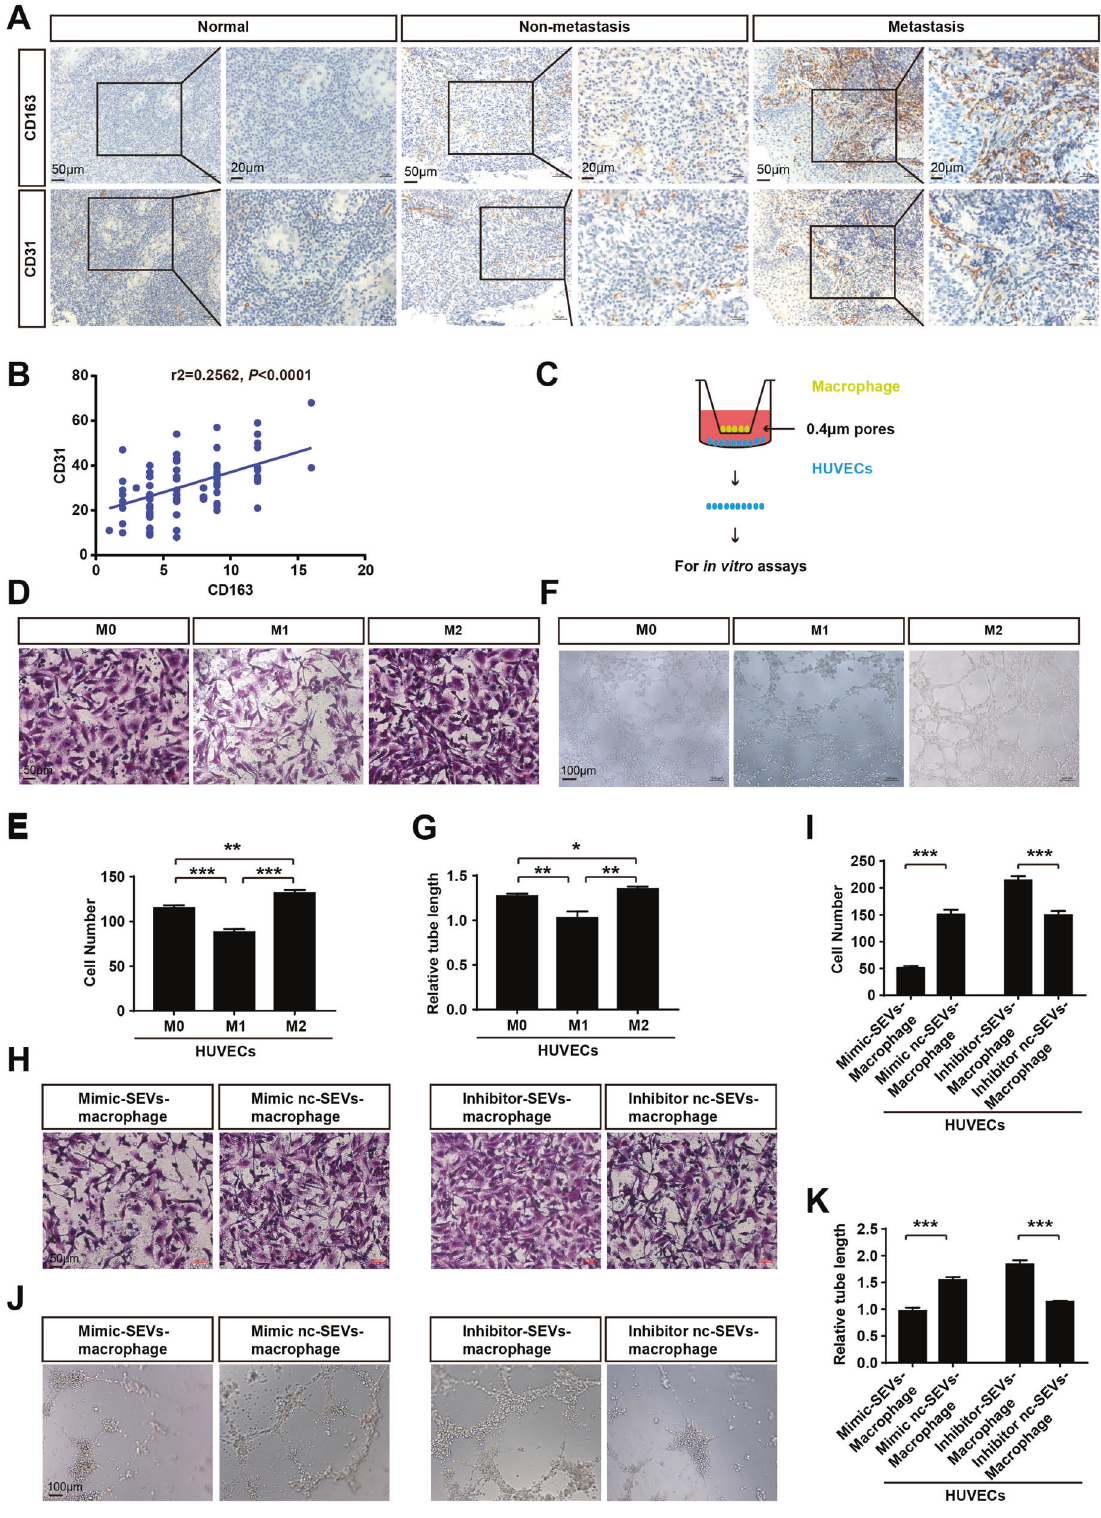
Fig. 4 MiR-6750-SEVs-incorporating macrophages inhibit angiogenesis. A Representative images of CD163/CD34 in tissues collected from graph-depicted groups. B Pearson correlation between miR-CD163 expression and MVD. Linear regression. C Scheme of HUVEC collection after co-cultured with macrophage. D , E Transwell migration assays were performed to measure cell migration. Student ’ s t-test. F , G Tube formation assays were performed using Matrigel. Student ’ s t-test. H , I Transwell migration assays were performed to measure cell migration. Student ’ s t-test. J , K Tube formation assays were performed using Matrigel. Student ’ s t-test.